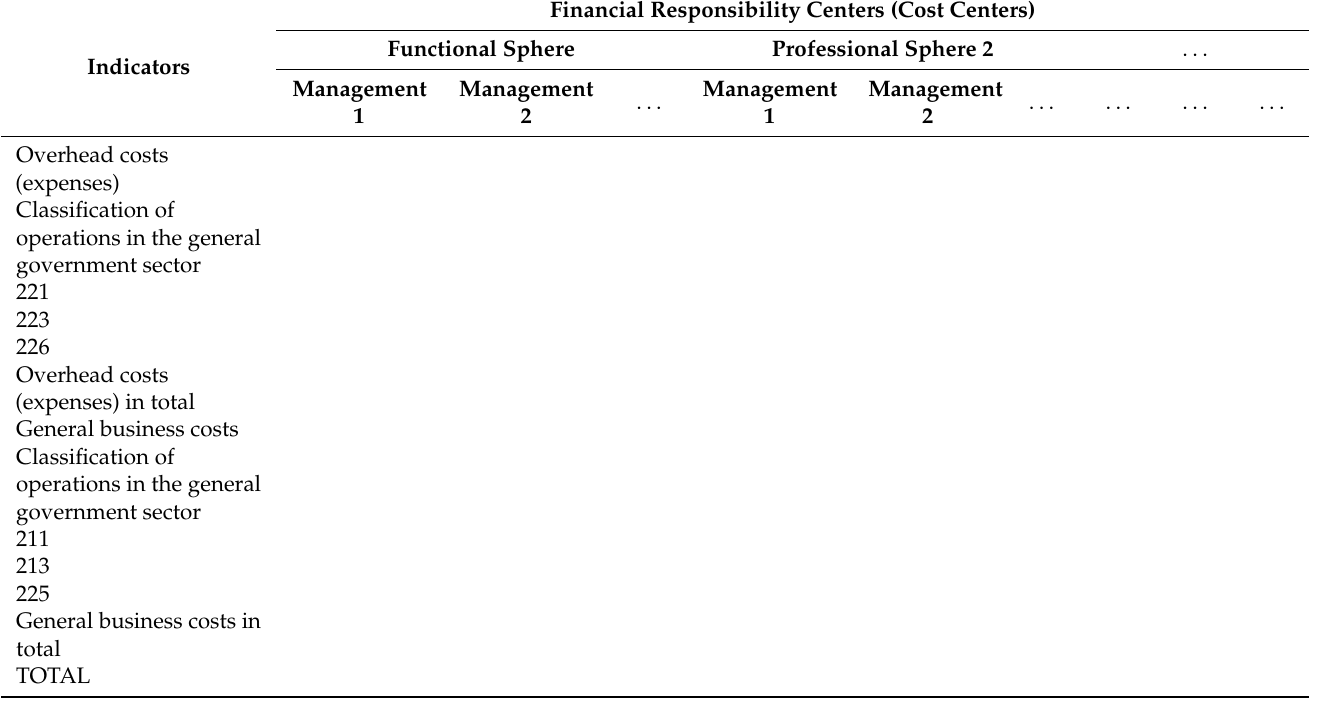
Table 4. The proposed form of the register “Estimated costs (expenses) by financial responsibility centers (cost centers)” (with due regard to conditional information)